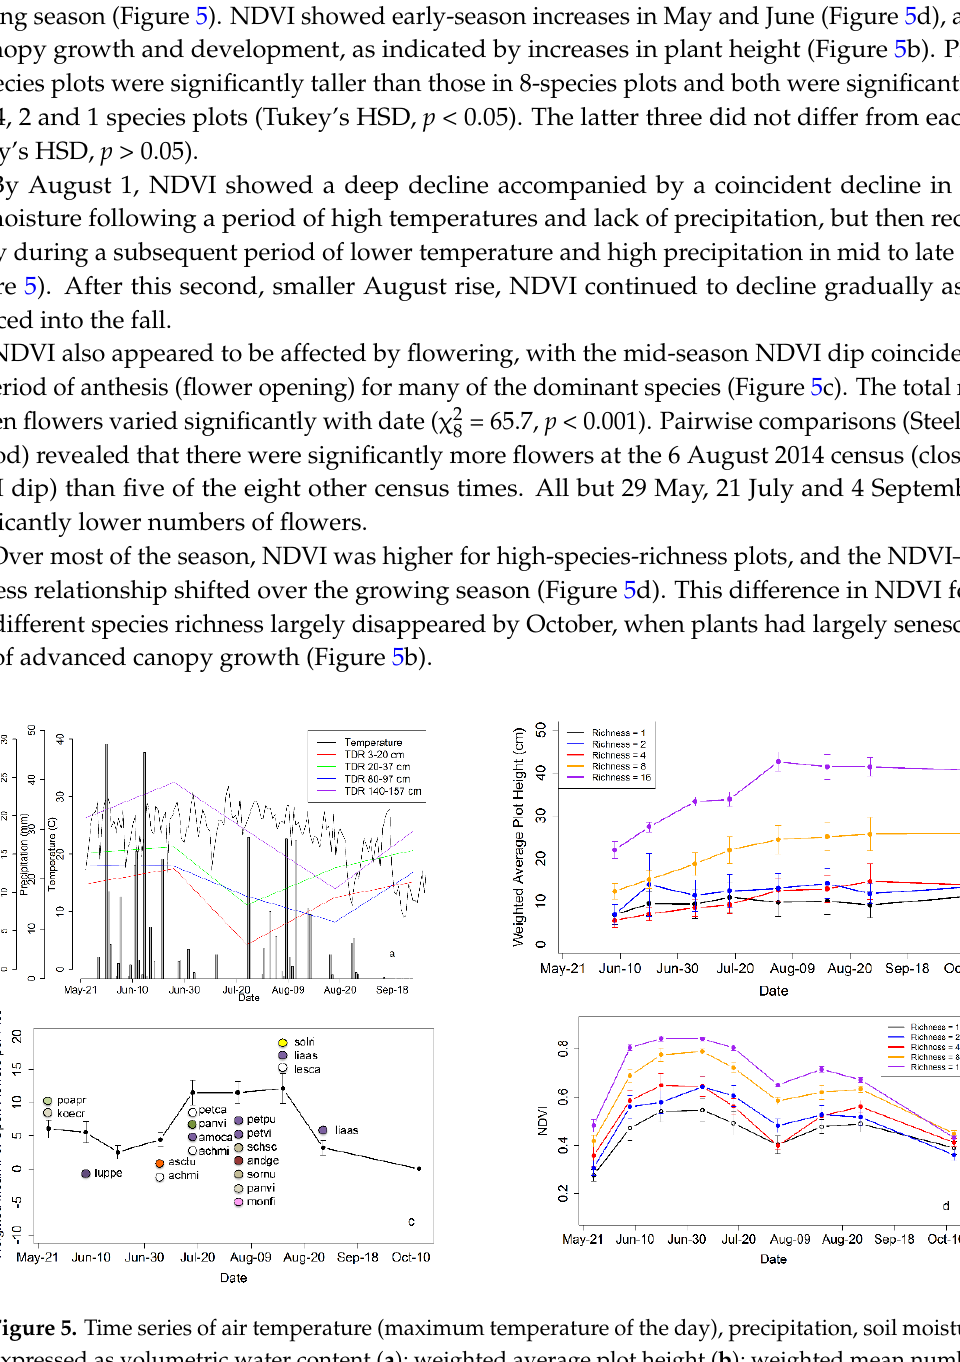
Figure 6. Representative examples of NDVI versus species richness at four time points (plots a – d ) in the 2014 growing season. These figures were derived from plot subsamples (17 measurements along the north most row of each plot) for 35 plots. Species richness represents the planted number of species per plot. Each richness treatment had a sample size of 6, except monoculture plots, which had